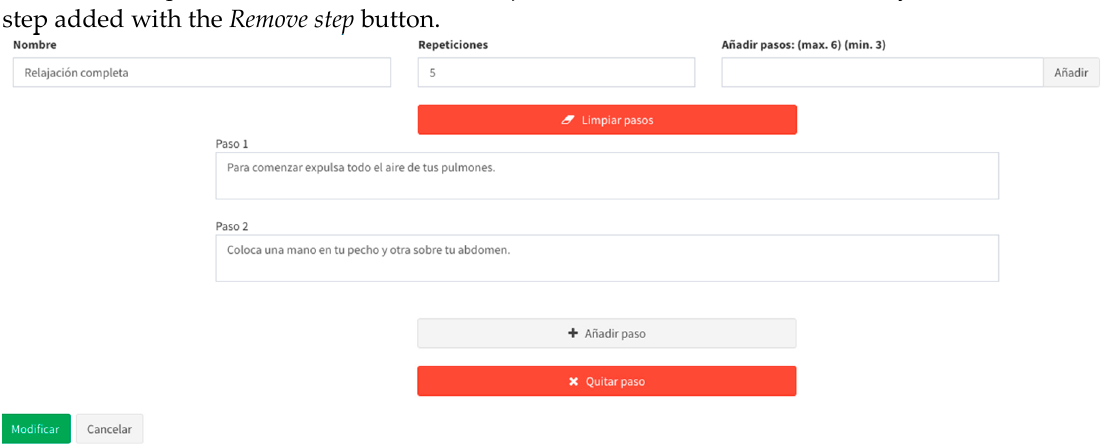
Figure 8. Screens of the web interface where the psychologists can manage the